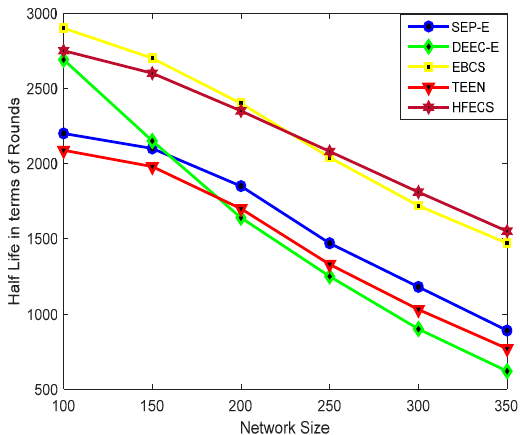
Figure 4. Half-life in terms of rounds against variable network size. Table 10. Percentage Improvement of HFECS in terms of half-life time.